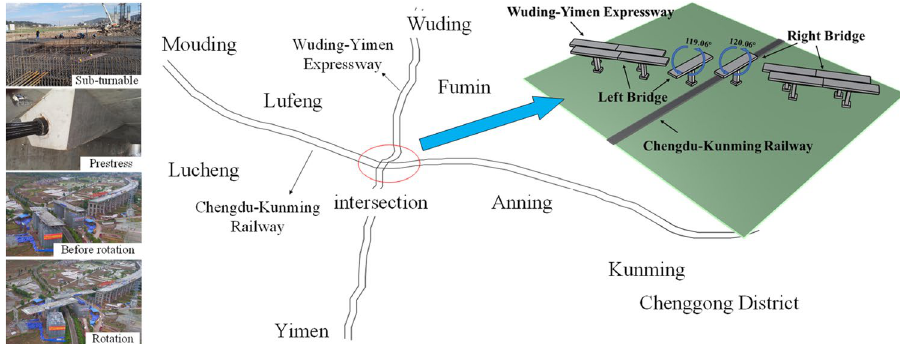
Figure 1. Layout of synchronous rotation.